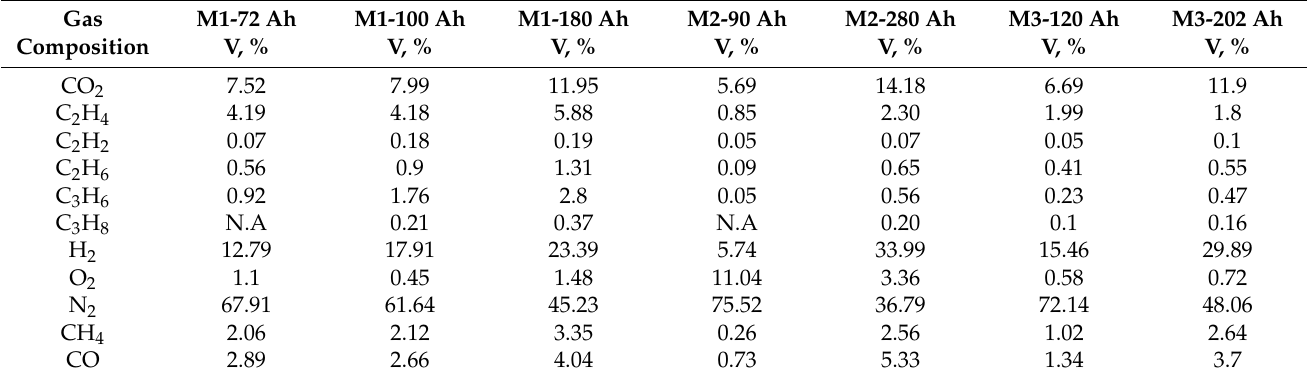
Table 3. Composition of thermal runaway release gas [64].